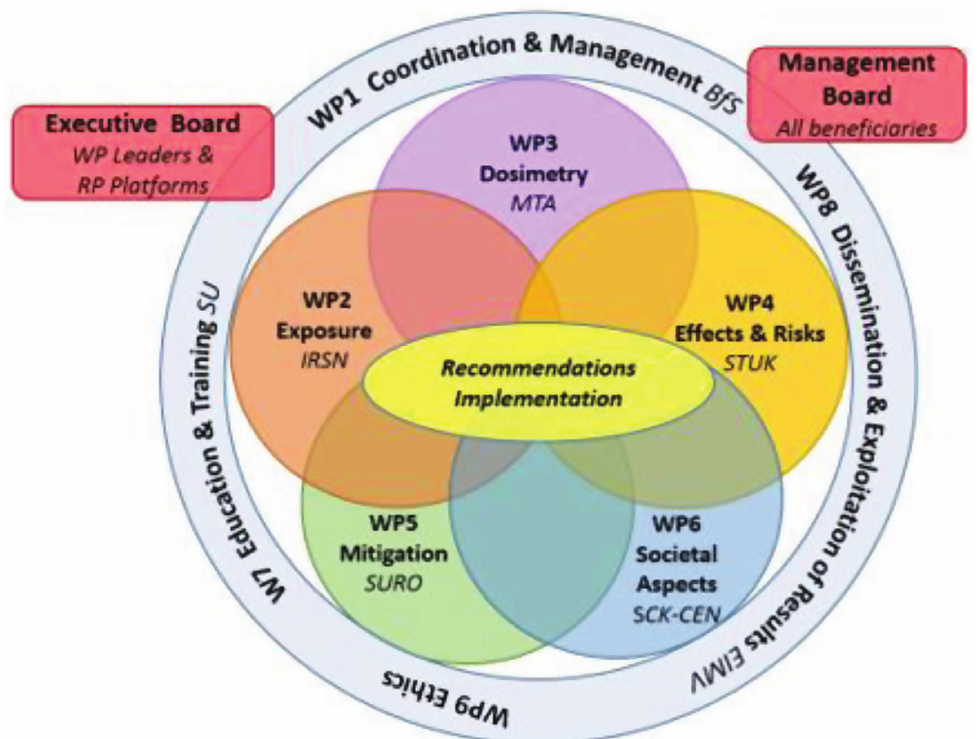
Fig. 2. Work package organisation in